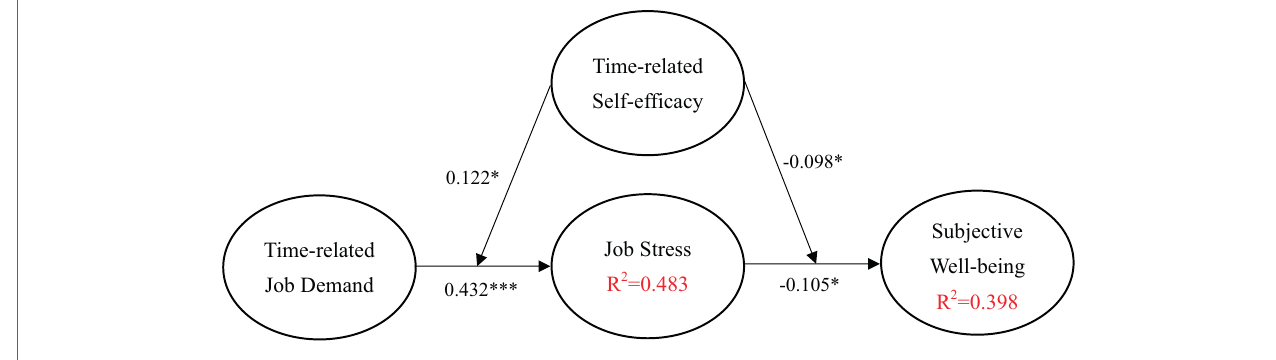
FIGURE 2 | Structural model. * p < 0.05; *** p < 0.001.